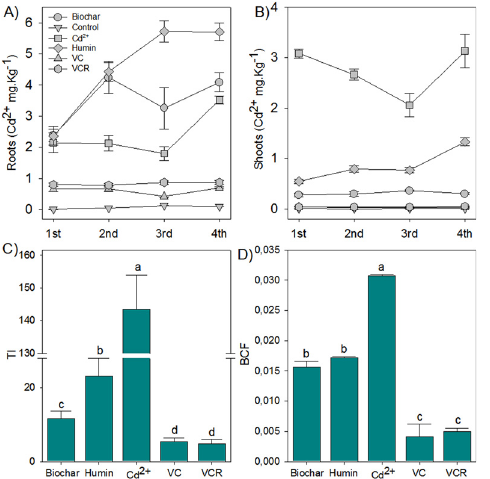
Fig 6. Root and Leaf Cd 2+ Contents of Rice Plants from the First Harvest until 28 Days after Seedling Transfer (DAT) (A and B); on the x axis, 1st, 2nd, 3rd and 4th indicate, respectively, the first, second, third and fourth harvests from each experiment, conducted at seven-day intervals. Values are reported as averages ± the standard error ( n = 30 ). (C) The translocation index (TI) and (D) the bioconcentration factor (BCF) were calculated at 28